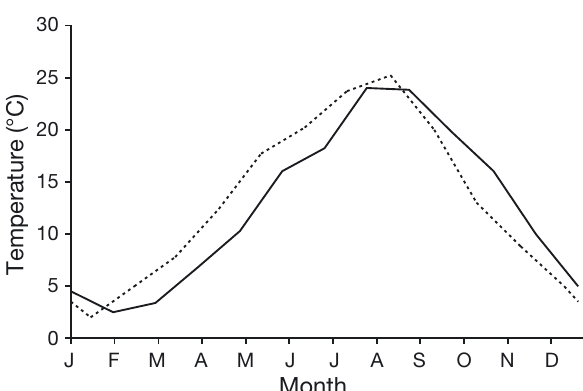
Fig. 2. Annual variation of temperatures in Sishili Bay (solid line) and culture pond (dotted line) off Shandong Peninsula, China